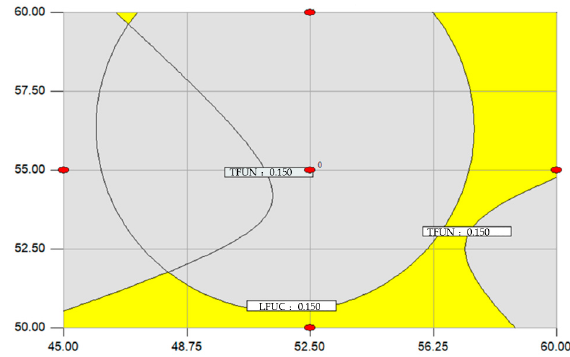
Figure 11. Angle–height response surface graph.